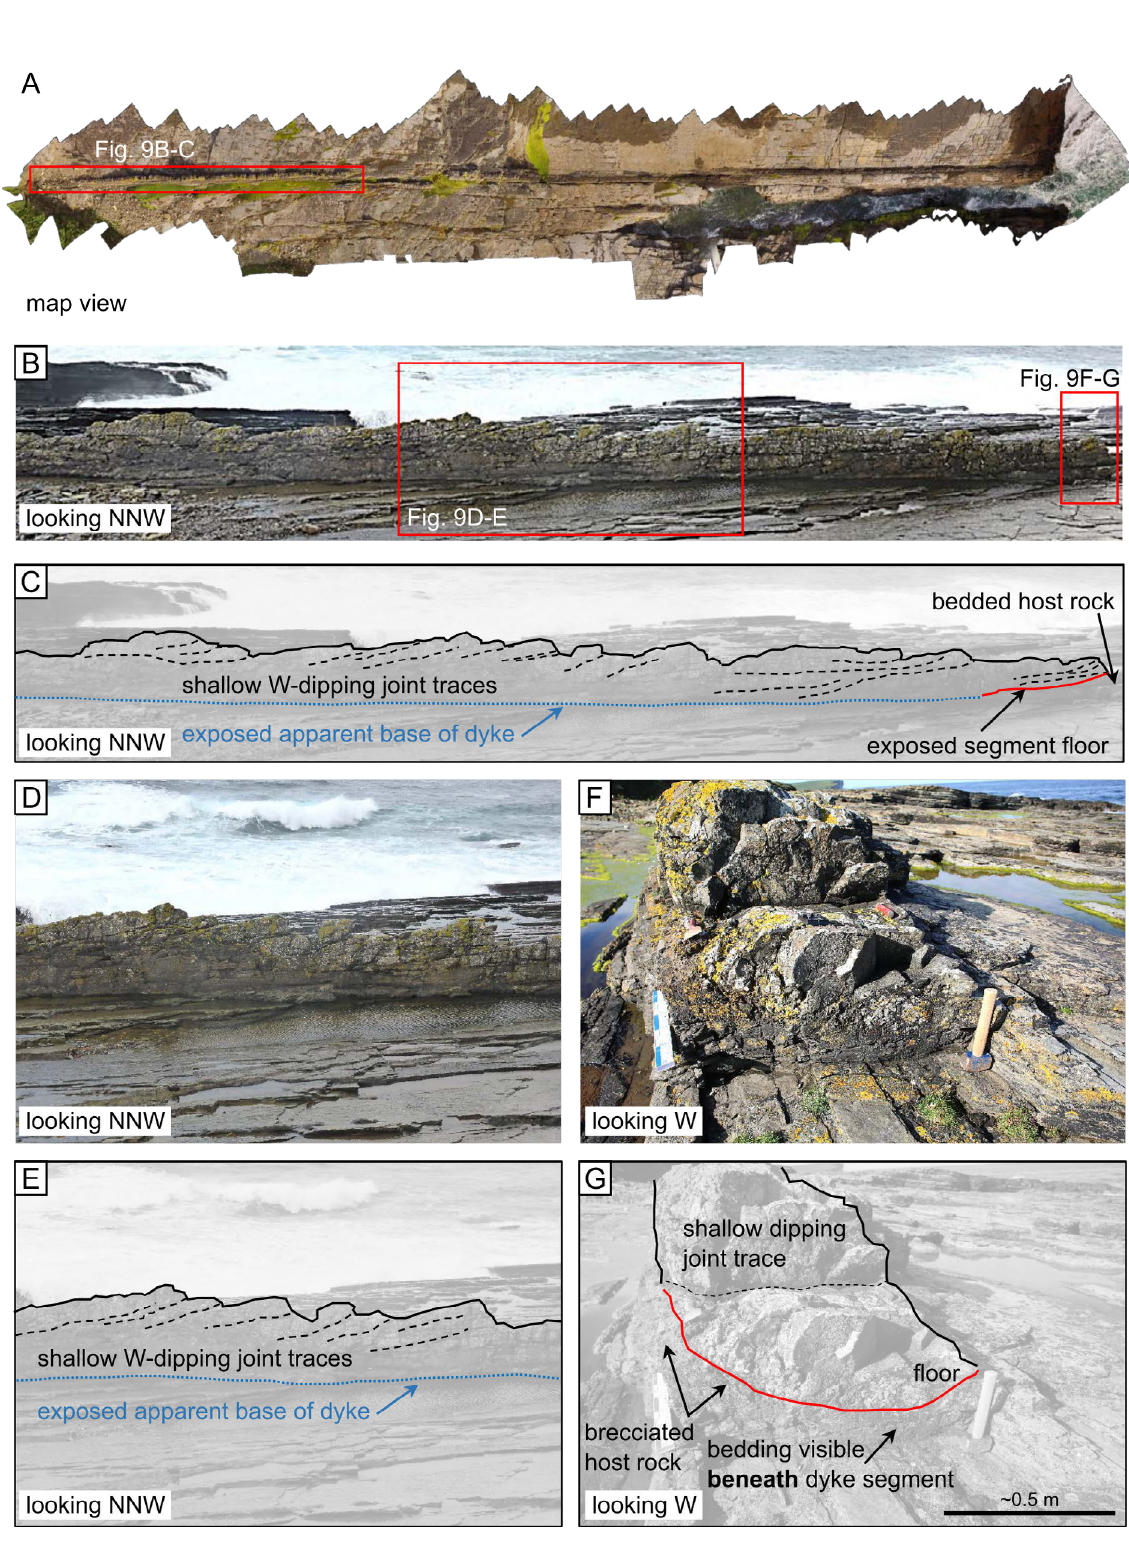
Figure 9: Caption on next